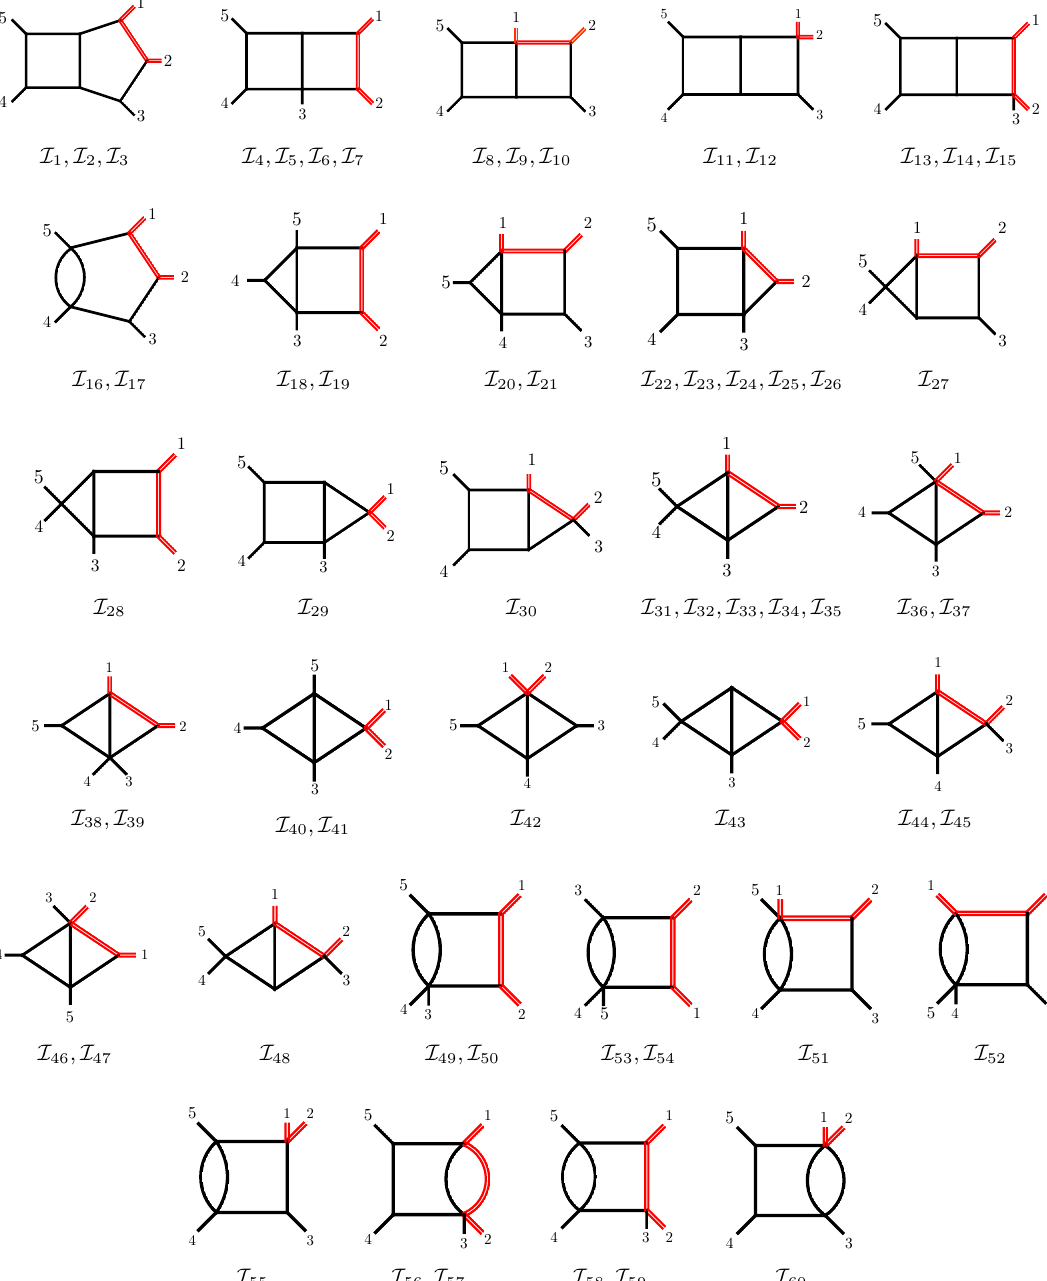
Figure 2 . The first 30 diagram topologies describing 60 out of 88 master integrals. The label of the individual sub-figures lists the master integrals belonging to the corresponding topology. Massive propagators and massive external momenta are indicated by red